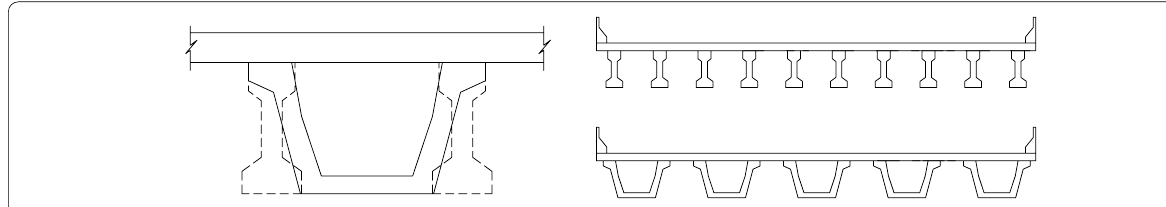
Fig. 1 Conceptual placement of prestressed concrete girders (reproduced from Ralls et al. [3])